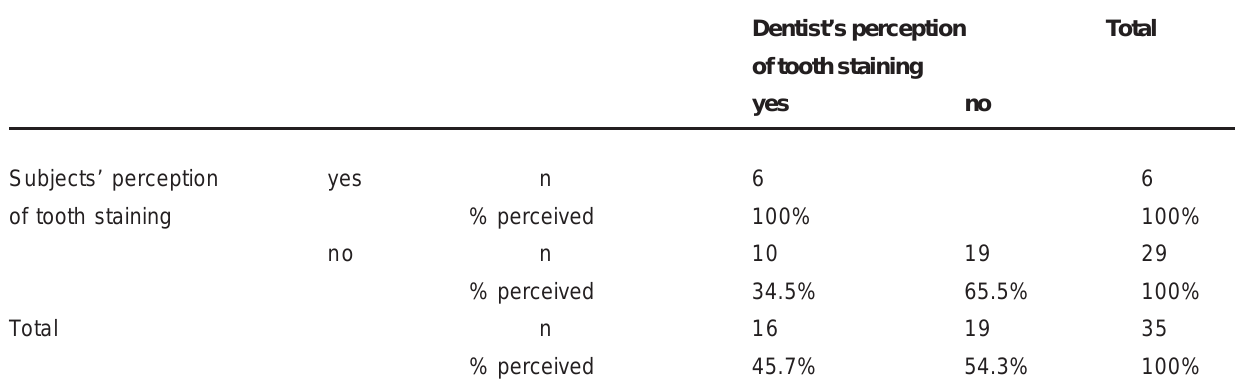
* Significant (p < 0.05)